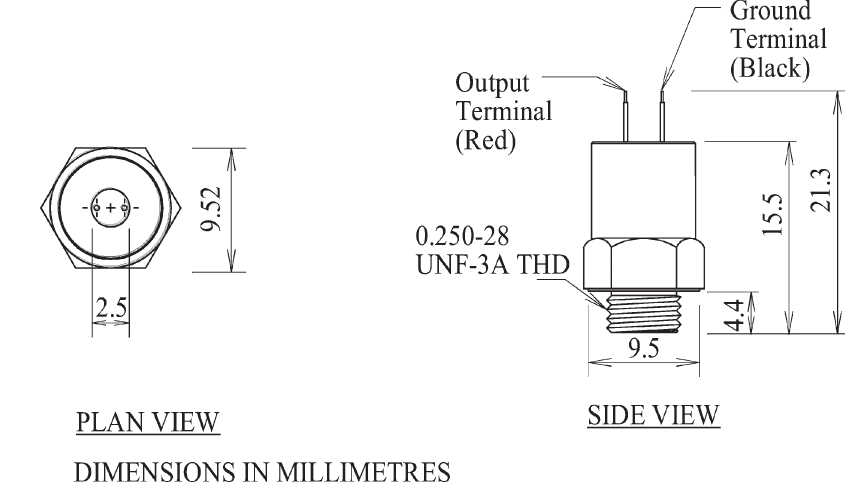
Fig. 2. Detail of Endevco 7255A-01 accelerometer with built-in mechanical filter.